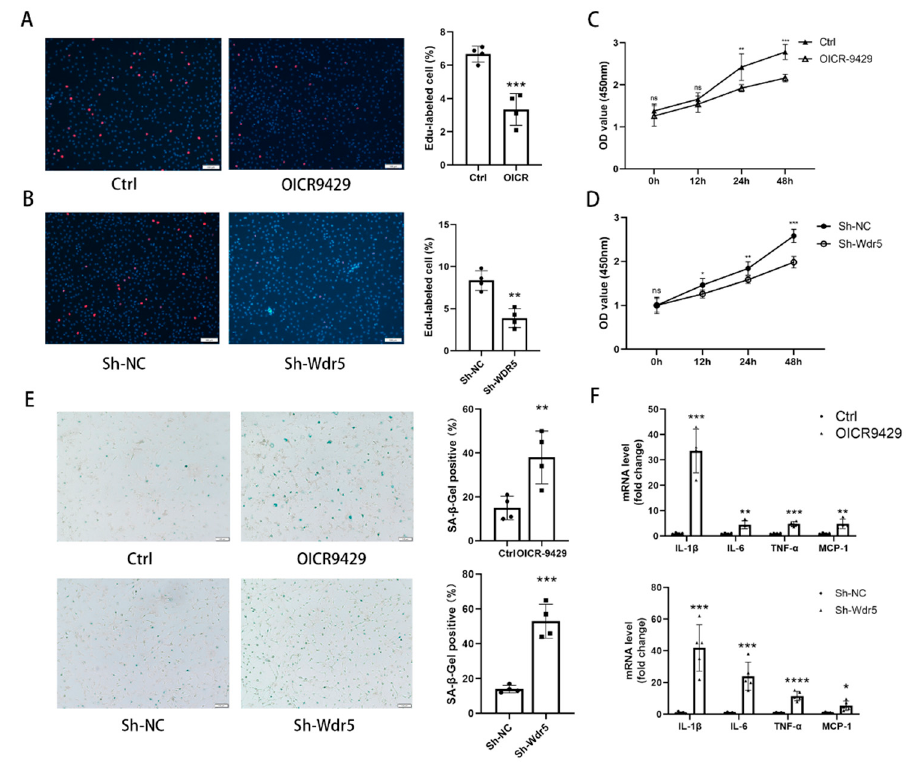
Figure 5. Wdr5 inhibition attenuated fibroblasts proliferation and induced cell senescence. ( A ) OICR-9429 application for 48 h inhibited the Edu incorporation in fibroblasts compared with a control group ( n = 4 in each group, >3 fields for each sample) ( B ) Sh-Wdr5 infection for 48 h inhibited the Edu incorporation in fibroblasts compared with Sh-NC ( n = 4 in each group, >3 fields for each sample). ( C , D ) CCK8 assay demonstrated that cell viabilities were inhibited after pharmacologic and genetical inhibition of Wdr5 ( n = 5 in each group). ( E ) SA- β Gal staining of OICR9429 or Sh-Wdr5 treated NRCFs. ( F ) mRNA levels of genes related to senescence-associated secretory phenotype. Scale bar 100 µm. Data are presented as mean ± SEM. * p < 0.05, ** p < 0.01, *** p < 0.001, **** p < 0.0001 between the 2 indicated groups.